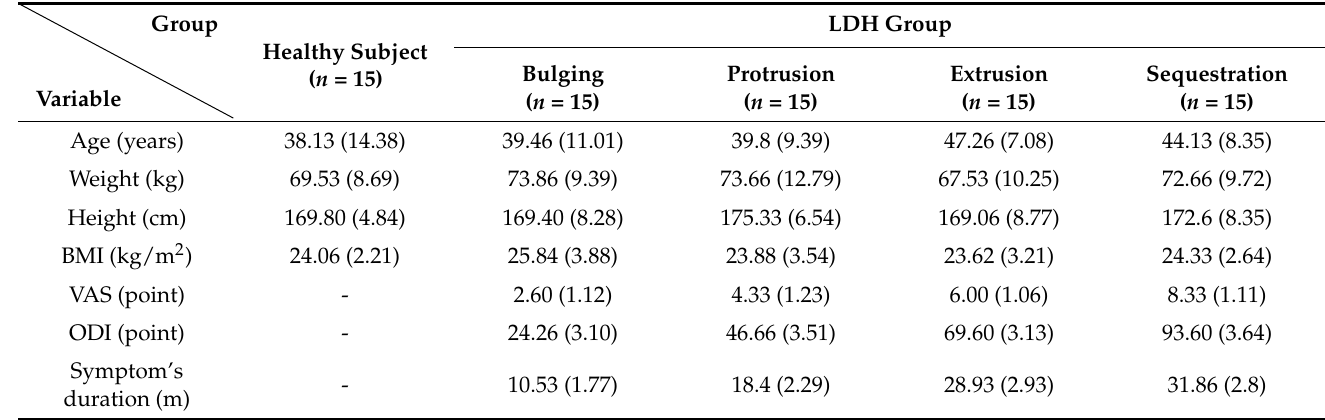
Table 1. Demographic and clinical characteristics of subjects (Mean ±